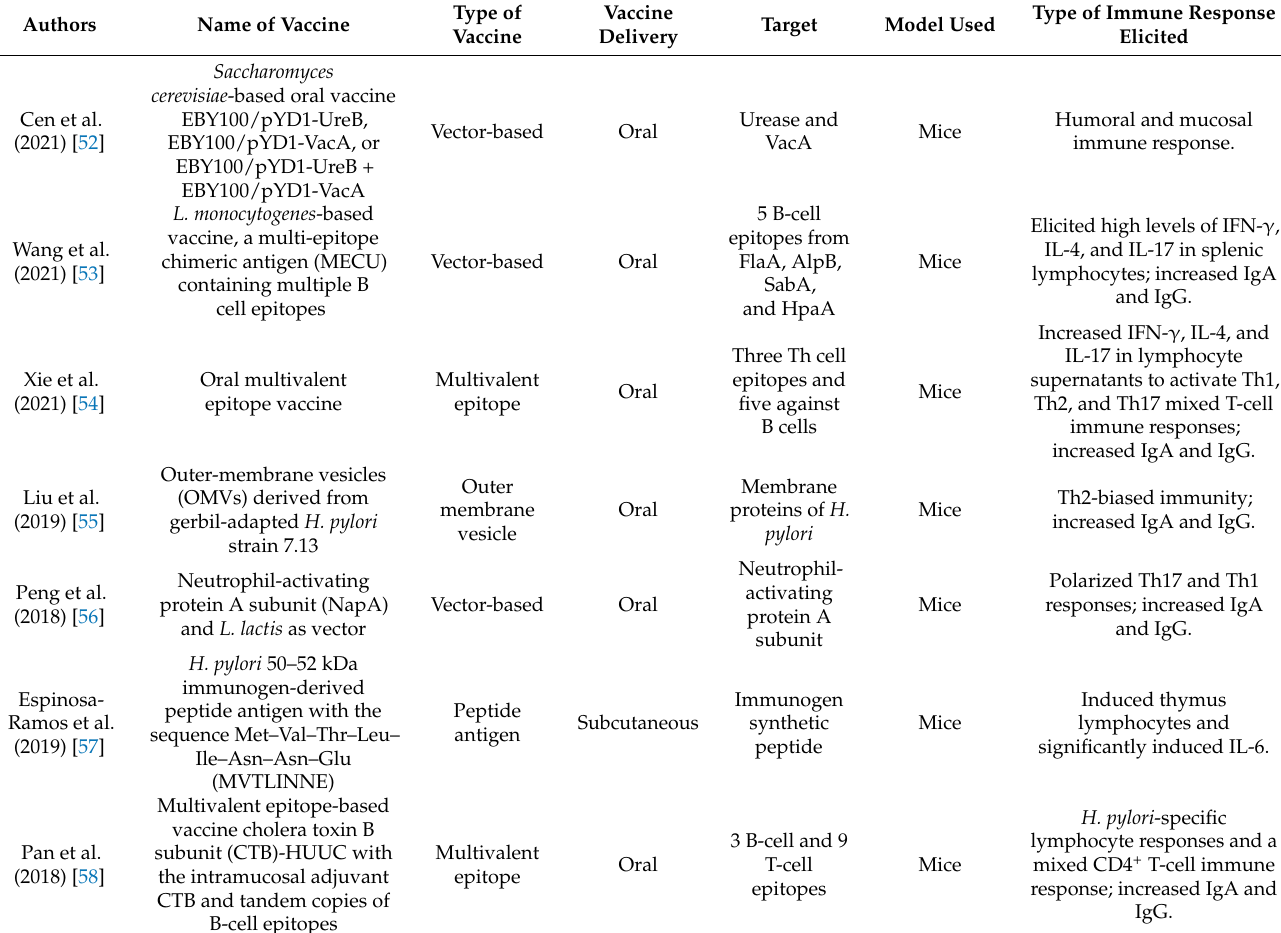
Table 2. List of vaccine candidates against H. pylori and their potent immune response in animal